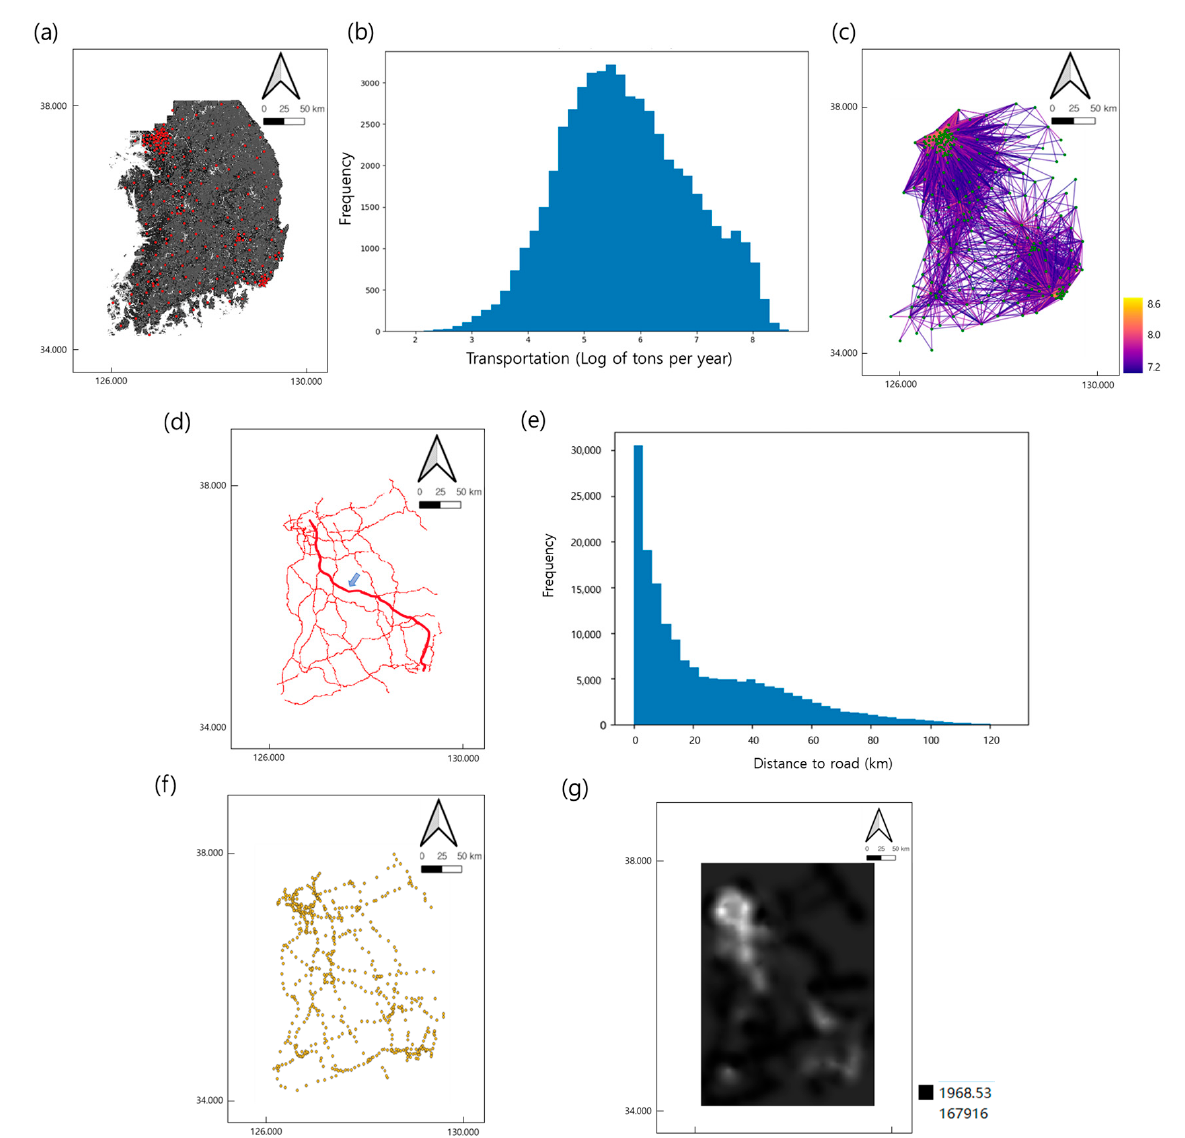
Figure 2. Position of capitals in municipal cities and counties within provinces in Korea (red dots) ( a ), frequency of edges (forest-product transportation between local areas) ( b ), edges over the threshold (7.0 in common log.) on the map (No. of nodes; 233, Threshold value; 7.0 (Log. of tons per year), and No. of edges; 8402) (green dots presenting local area capitols) ( c ), highway network in the southern peninsula of Korea (thick red line indicated by an arrow to present the Gyeongbu Highway from Busan to Seoul) ( d ), frequencies of distances from all spatial units to the nearest point of highway ( e ), and sampling points for traffic load (no. of cars per day) in Korea in the highway network ( f ) with kriging data ( g ).